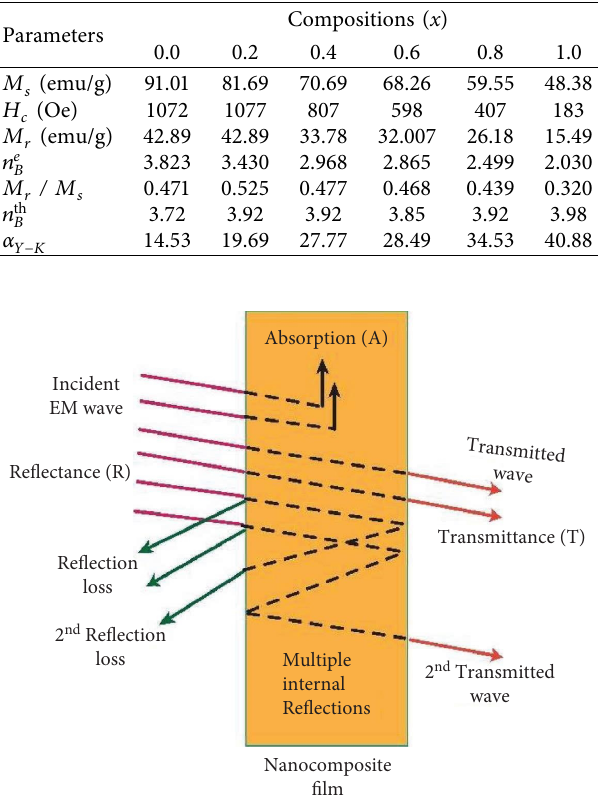
Figure 15: Schematic illustration of EMI shielding mechanism based on Co 1 − x Ni x Fe 2 O 4 /PVA